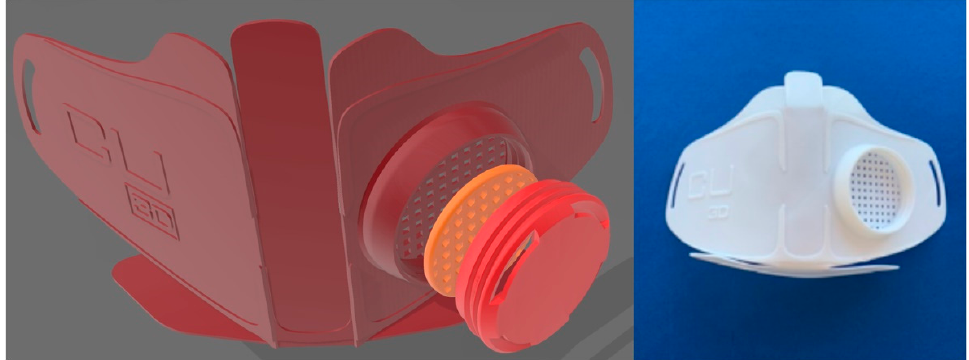
Figure 13. Model of the Copper3D NanoHack mask ( left ), showing a step in the creation of the mask. A 3D ‐ printed replica of this mask ( right ). Figure reproduced from [149].